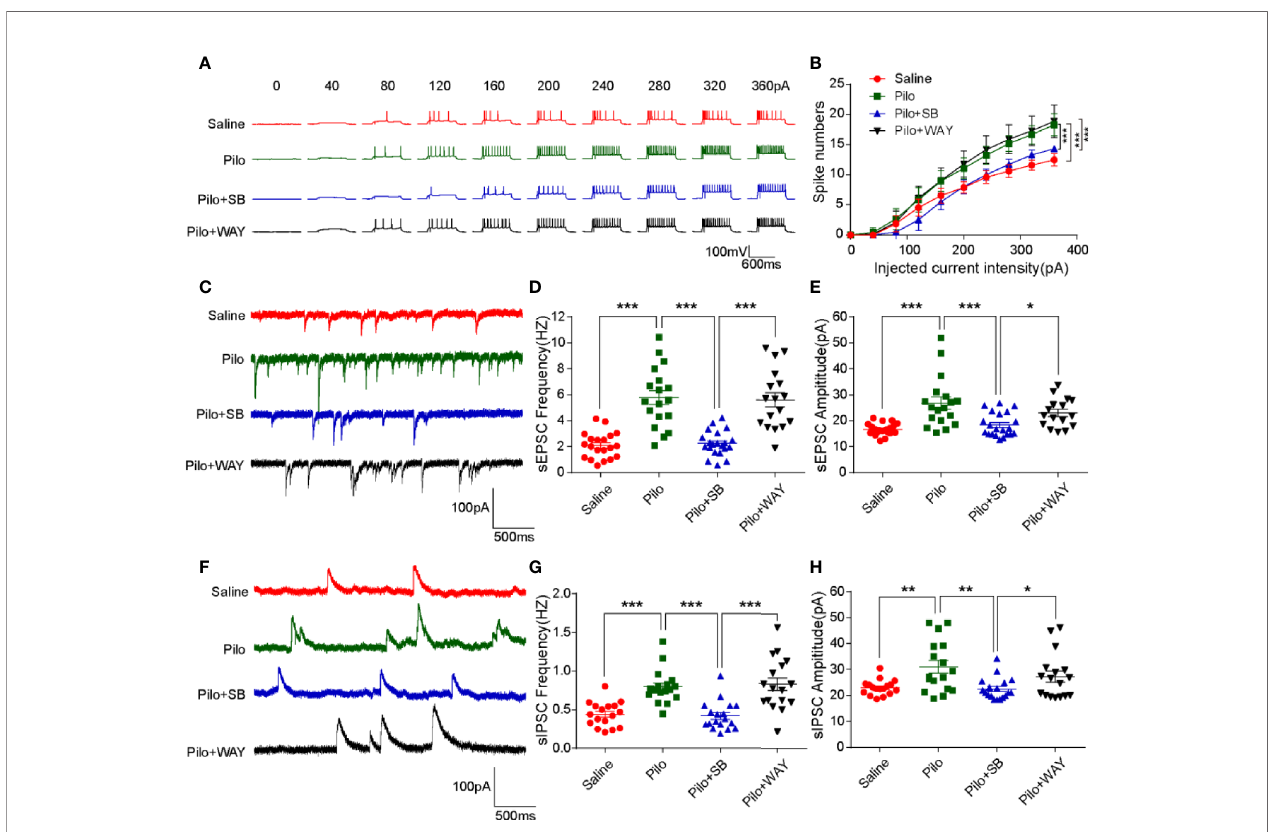
FIGURE 3 | Antagonism of 5-HT6R with SB271046 inhibited hippocampal pyramidal neuronal excitability. (A) Representative traces of evoked action potential (APs) in response to various depolarization currents injected into individual hippocampal neurons. (B) Quanti fi cation of evoked action potentiation. The number of spikes in the Pilo group increased signi fi cantly when compared with the Saline group and decreased notably after SB271046 treatment, while WAY181187 treatment produced no signi fi cant change. For comparing: ANOVA, F (3,686) = 12.962, p < 0.001; for the Saline group (n=17/6) vs. the Pilo group (17/5): p = 0.0002; for the Pilo group vs. the Pilo+SB group (n=18/6), p = 0.0003; for the Pilo+SB group vs. the Pilo+WAY group (n=17/6), p < 0.001. Signi fi cance was determined using two- factor mixed ANOVA followed by the Bonferroni post hoc test. (* p < 0.05, ** p < 0.01, *** p < 0.001). (C) Representative sEPSC traces of the four groups. (D) Statistic analysis of sEPSC frequency. For comparing sEPSC frequency: ANOVA, F (3,72) =26.655, p < 0.001; for the Saline group vs. the Pilo group: p < 0.001; for the Pilo group vs. the Pilo+SB group, p < 0.001; for the Pilo+SB group vs. the Pilo+WAY, p < 0.001. (E) Statistic analysis of sEPSC amplitude. For comparing sEPSC amplitude: ANOVA, F (3,71) = 10.750, p < 0.001; for the Saline group vs. the Pilo group: p < 0.001; for the Pilo group vs. the Pilo+SB group, p = 0.0003; for the Pilo+SB group vs. the Pilo+WAY, p = 0.0256. (F) Representative sIPSC traces of the four groups. (G) Statistic analysis of sIPSC frequency. For comparing sIPSC frequency: ANOVA, F (3,65) = 15.715, p < 0.001; for the Saline group vs. the Pilo group: p = 0.0002; for the Pilo group vs. the Pilo+SB group, p = 0.0001; the Pilo +SB group vs. the Pilo+WAY group, p < 0.001. (H) Statistic analysis of sIPSC amplitude. For comparing sIPSC amplitude, ANOVA, F (3,65) = 5.578, p = 0.0018; for the Saline group vs. the Pilo group: p = 0.0092; for the Pilo group vs. the Pilo+SB group, p = 0.0037; for the Pilo+SB group vs. Pilo+WAY, p = 0.0486. Statistical comparisons were performed with one-way analysis of variance (ANOVA, p < 0.05) followed by the Bonferroni post-hoc test (* p < 0.05, ** p < 0.01, *** p <